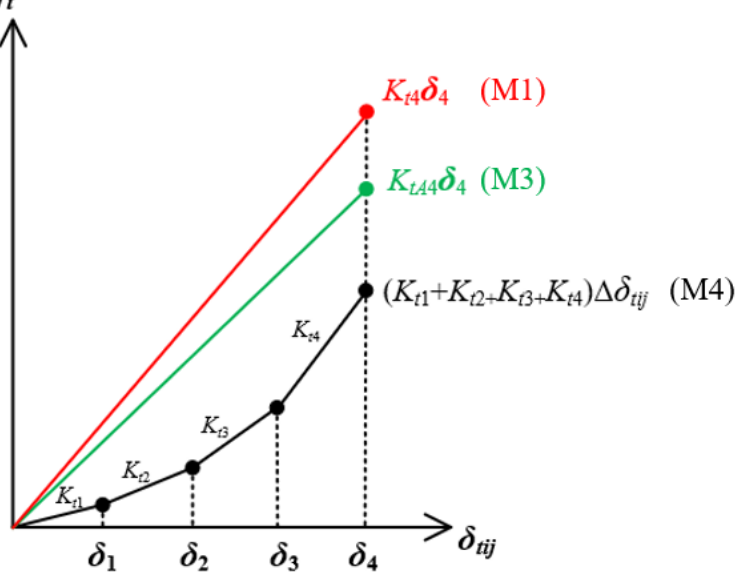
Figure 2. Loading comparison between three different MD models.